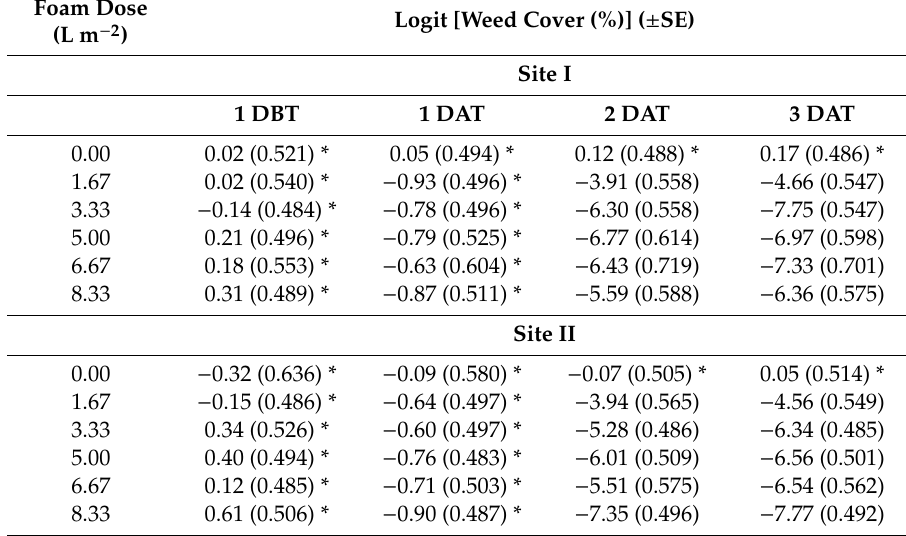
Table 3. Least squares means and standard error s (SE) of weed cover percentage logit transformed as a ff ected by the foam dose, the site, and the evaluation date (one day before and one, two and three days after treatments) in the Festuca arundinacea (Schreb.) infested field experiment. Foam Dose (L m − 2 ) Logit[Weed Cover (%)] (±SE) Site I